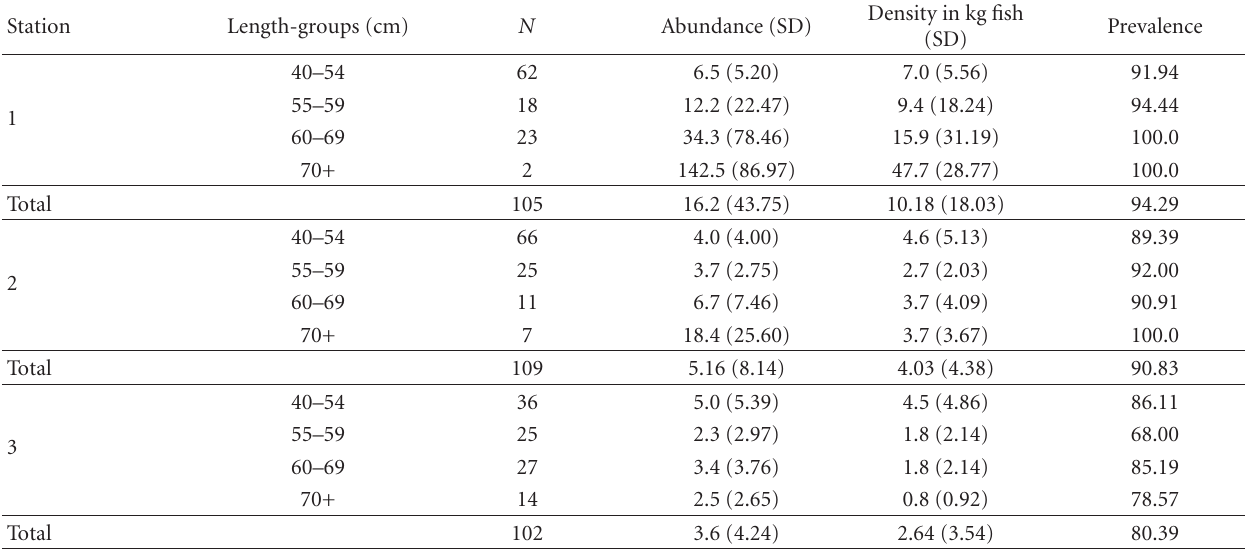
Table 2: Abundance, density, and prevalence of Pseudoterranova larvae in the four length-groups cod ( Gadus morhua ) from the three catch